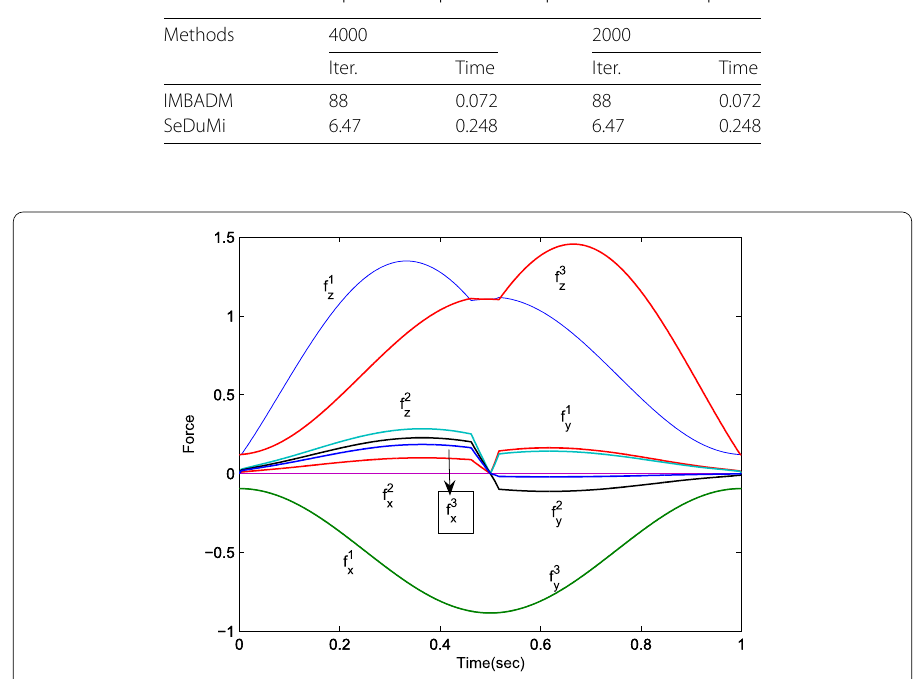
Figure 1 The trajectories of forces for 4000 FOPs by the IMBADM